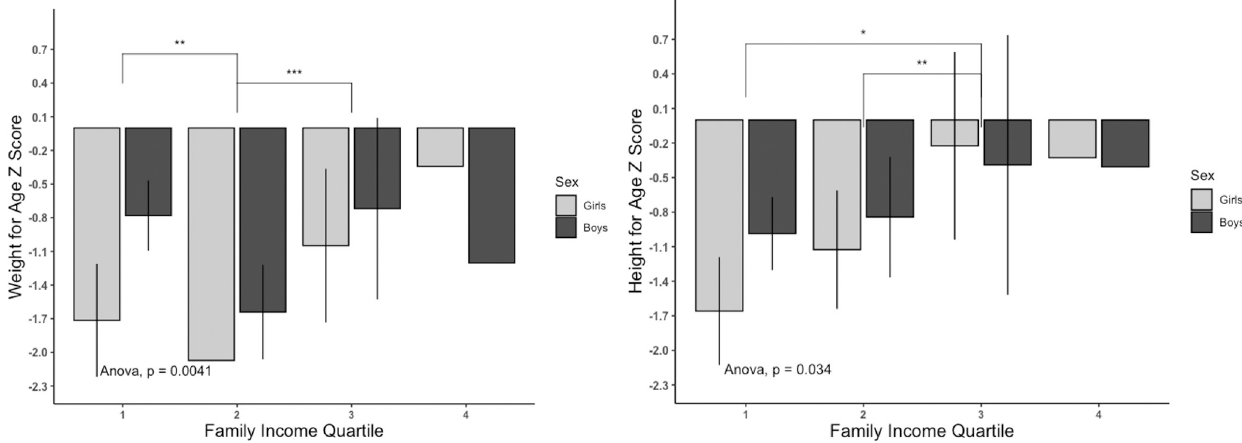
Fig 8. Weight-for-age Z score and height-for-age Z score of children of age 2–15 years plotted against family income quartile (n = 330) [N.B.: Family income quartile 1 = < 7000 BDT, 2 = 7000–11999 BDT, 3 = 12000–20000 BDT, 4 = > 20000].